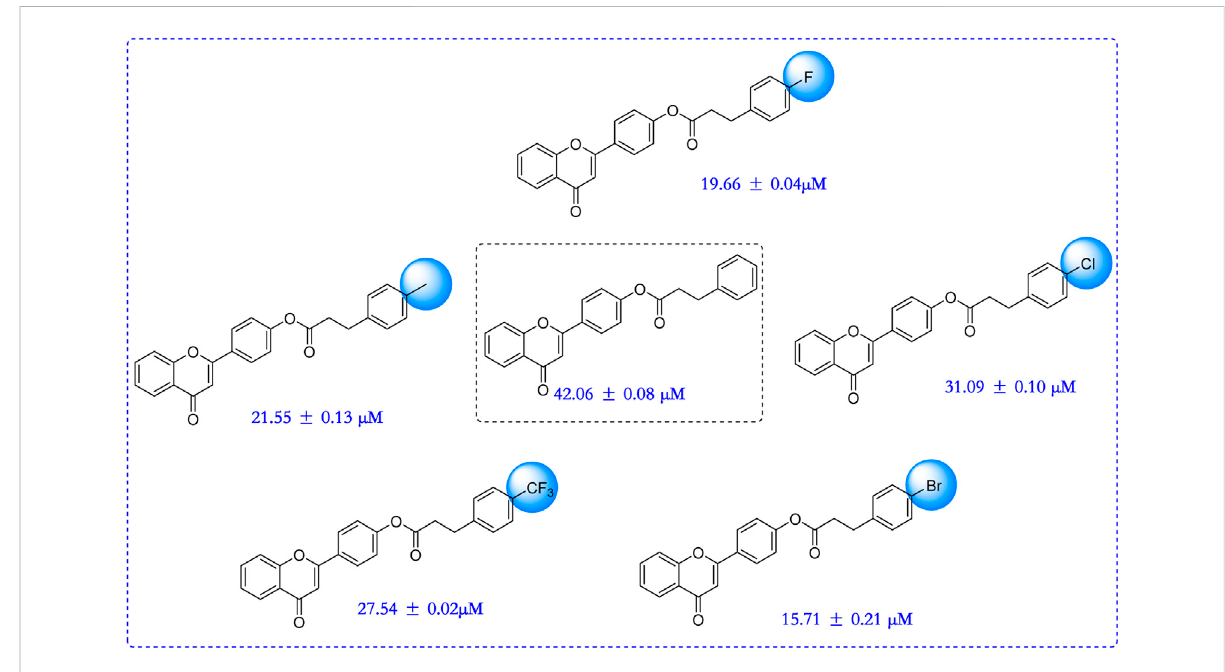
FIGURE 2 SAR analysis of synthesized six fl avonoid derivatives.